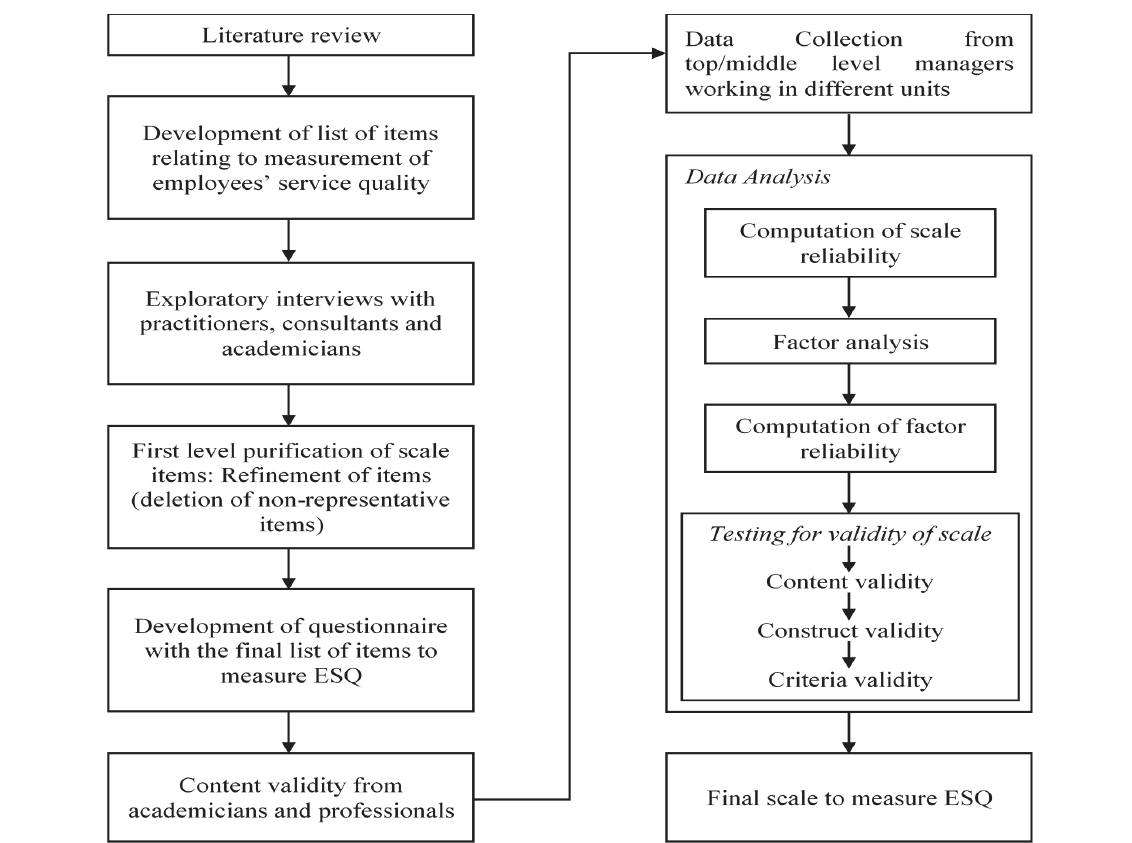
Fig. 2. Research methodology for developing a scale for measuring Employees’ Service